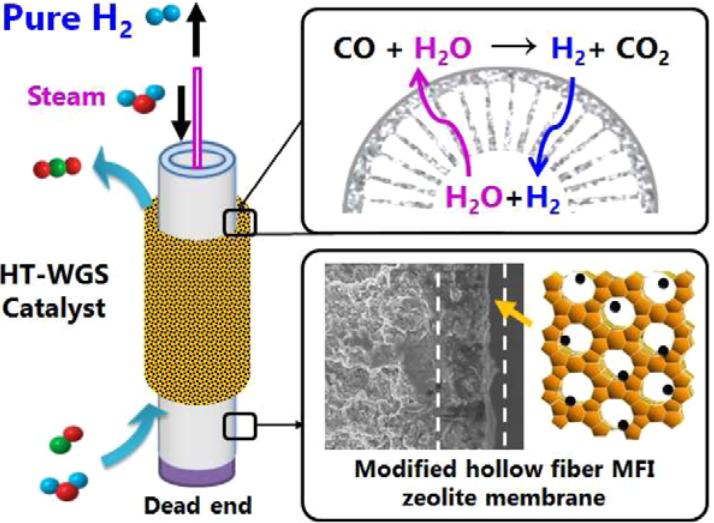
Figure 6. Schematic illustration of a WGS membrane reactor with modified hollow